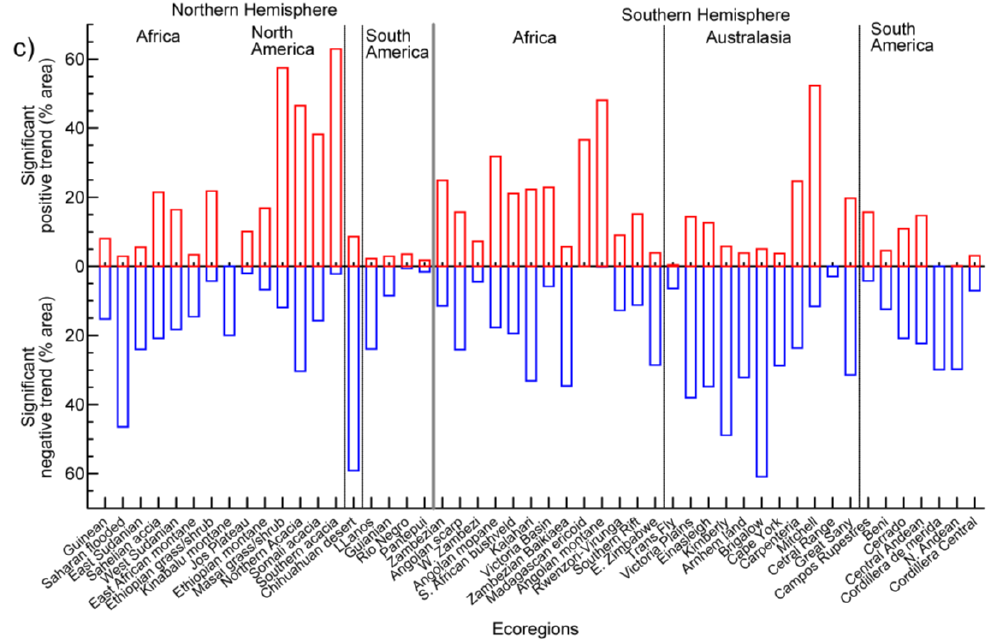
Figure 10. Area (%) of savanna, woodland and shrubland WGT Ecoregions showing significant monotonic trends in ( a ) F PV ; ( b ) F NPV ; and ( c ) F BS .